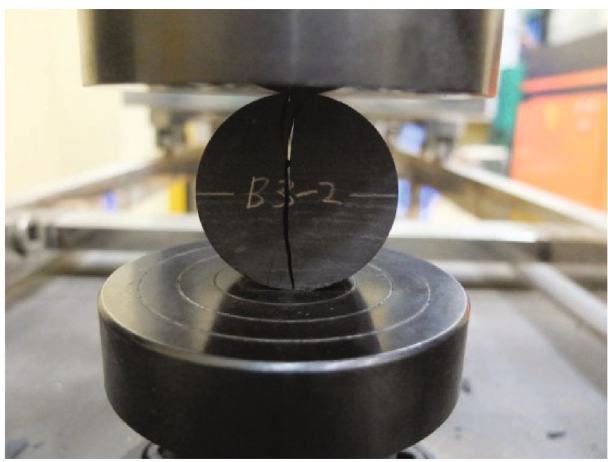
Figure 3: Brazilian splitting test of shale rock.